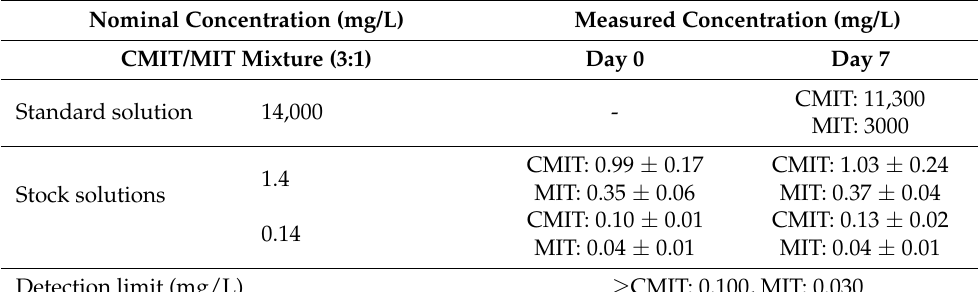
Table 1. Nominal concentration of CMIT/MIT mixture and concentrations of CMIT and MIT mea- sured with HPLC. CMIT/MIT mixture solutions were diluted in M4 medium and measured after 7 days. The measured concentrations are presented as means ±